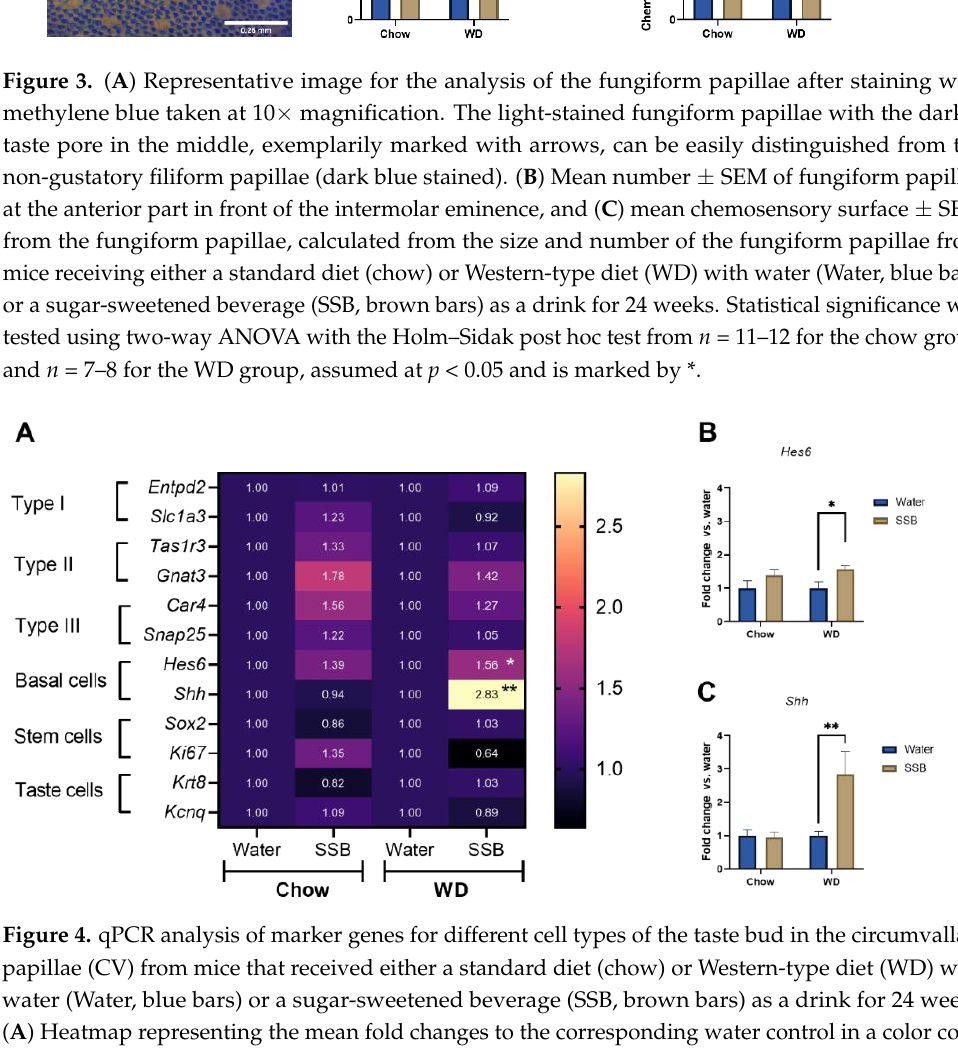
Figure 4. qPCR analysis of marker genes for different cell types of the taste bud in the circumvallate papillae (CV) from mice that received either a standard diet (chow) or Western-type diet (WD) with water (Water, blue bars) or a sugar-sweetened beverage (SSB, brown bars) as a drink for 24 weeks. ( A ) Heatmap representing the mean fold changes to the corresponding water control in a color code. ( B , C ) Gene expression analysis of Hes6 and Shh . Statistical significance was tested using two-way ANOVA with the Holm–Sidak post hoc test or Student’s t -test, assumed at p < 0.05. * p <